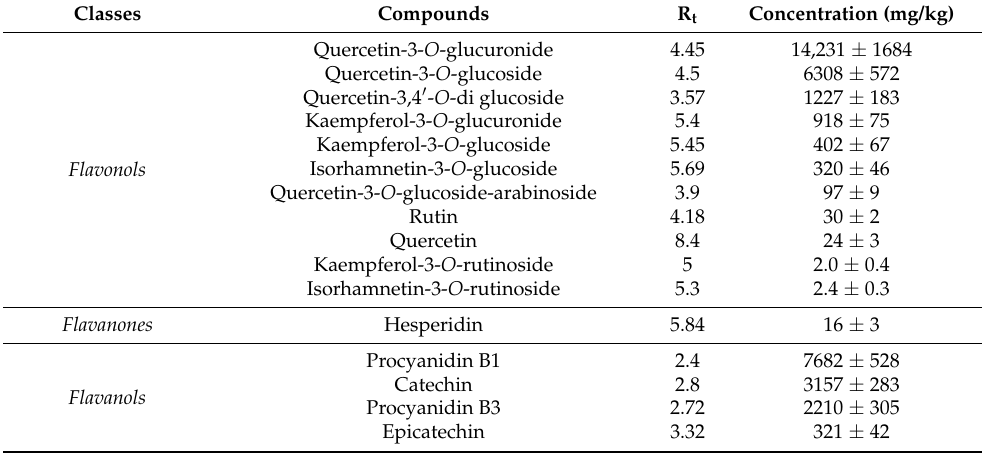
Table 1. Identification and quantification of phenolic and polyphenolic compounds present in white grape juice extract (WGJe) analyzed by UPLC/QqQ–MS/MS, subdivided into the corresponding chemical classes and expressed as mean ±